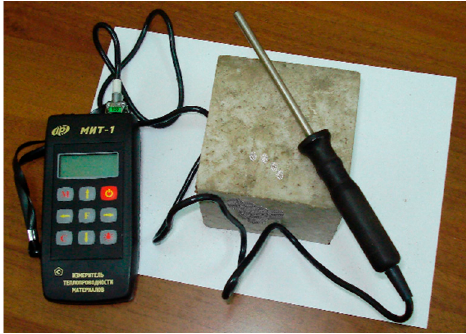
Figure 1. Device for determining the thermal conductivity.